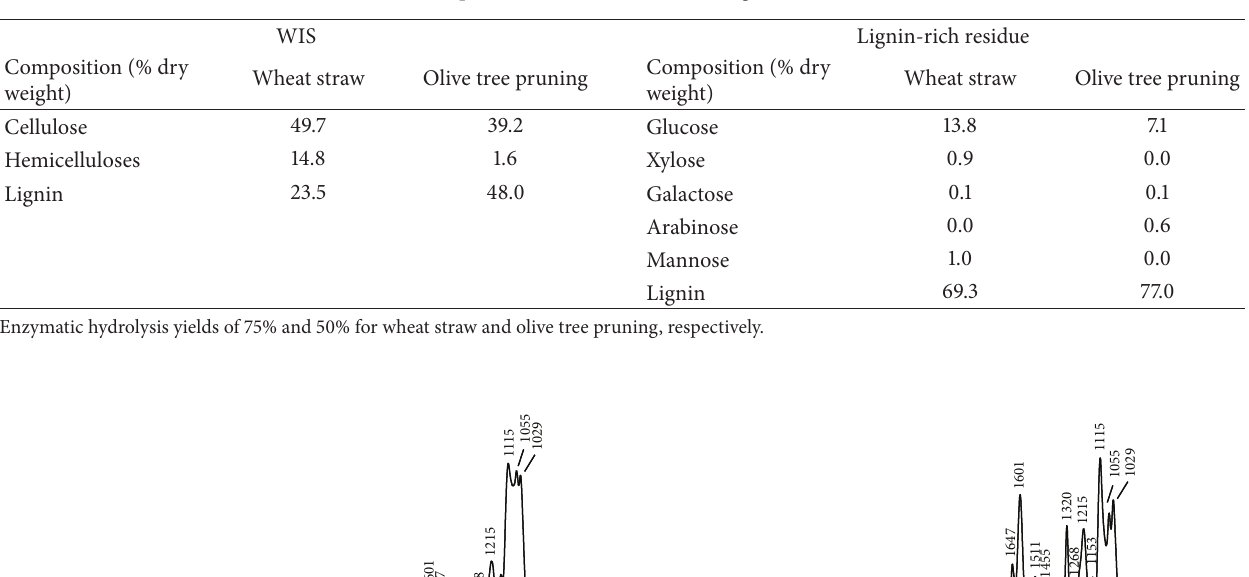
Table 1: Composition of WIS fractions and lignin-rich residues.